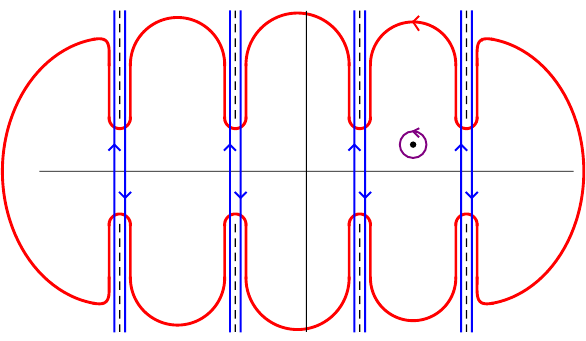
Figure 1 . The deformation of the contour used to produce the dispersion relation for a five-point function. We start with the small purple circle about the point τ , then puff up the contour into the red caterpillar shape, avoiding the branch cuts that start at τ , and finally trade the caterpillar k ± iy for the series of vertical blue lines, one on each side of the branch cuts, assuming, because of cluster decomposition, that we can discard the portions of the contour at